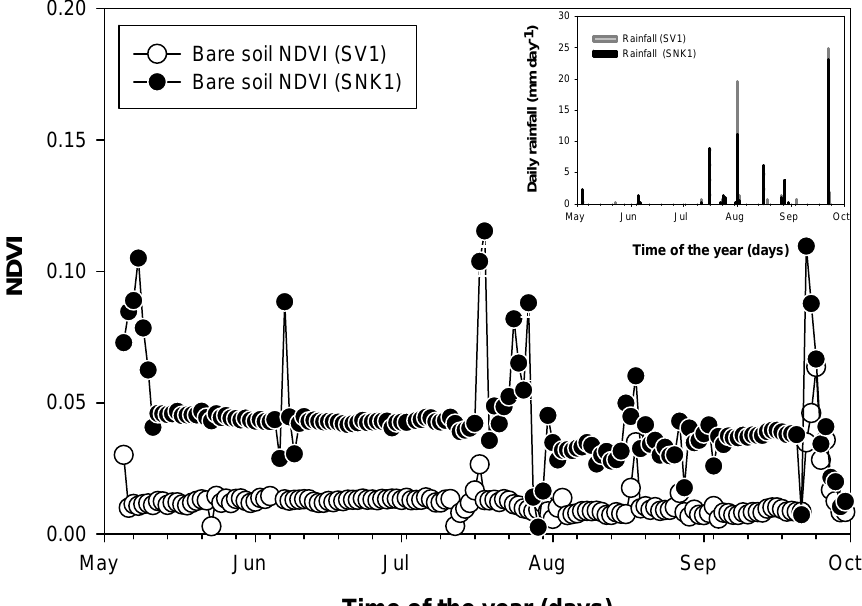
Figure 5. Time series of average midday (11:30-13:30h) NDVI values of a bare soil surface at Spring Valley 1 site and at Snake Valley 1 site. Data were acquired during the experimental period from May 5 to September 30, 2007. Average daily rainfall data acquired from a weather station at the two sites are illustrated for the same experimental